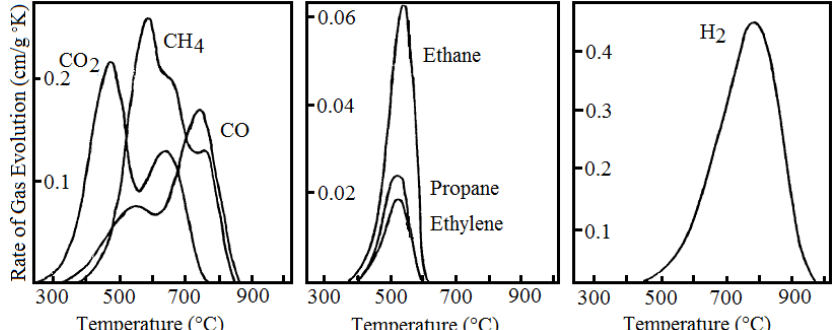
Figure 51. Effect of temperature of gas evolution during the pyrolysis of Wyodak coal at a heating rate of 3.33 °C/min under atmospheric pressure on a dry basis (reproduced from Juntgen and van Heek [105]).